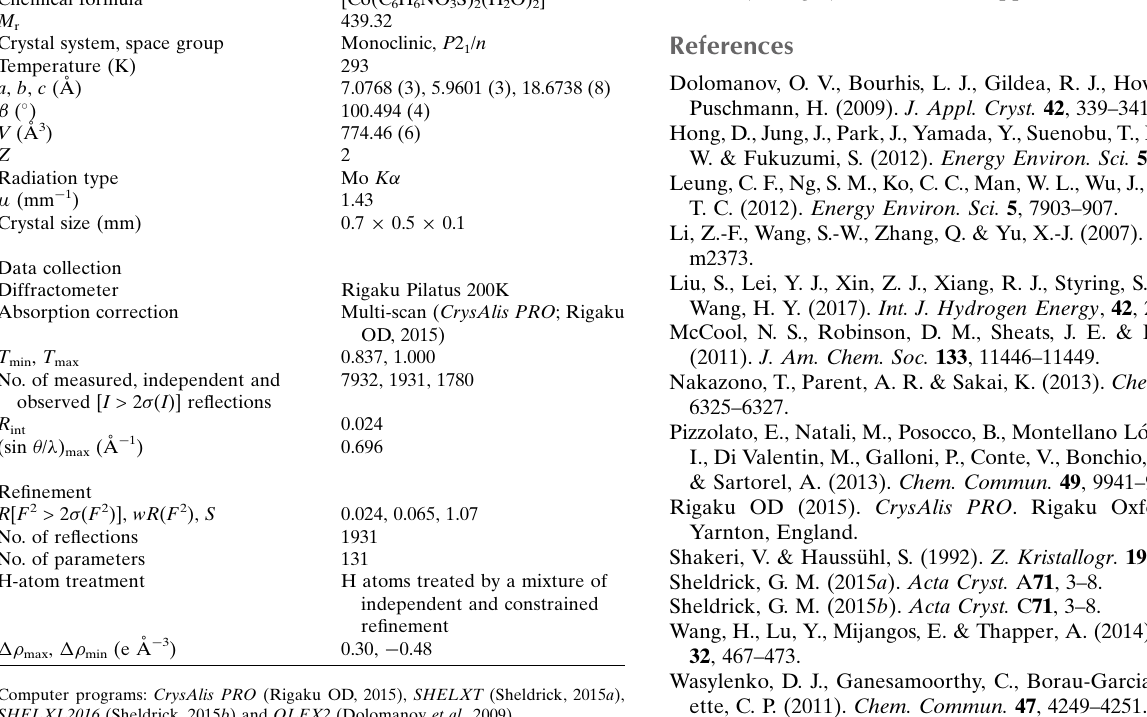
Table 2 Experimental details. Crystal data Chemical